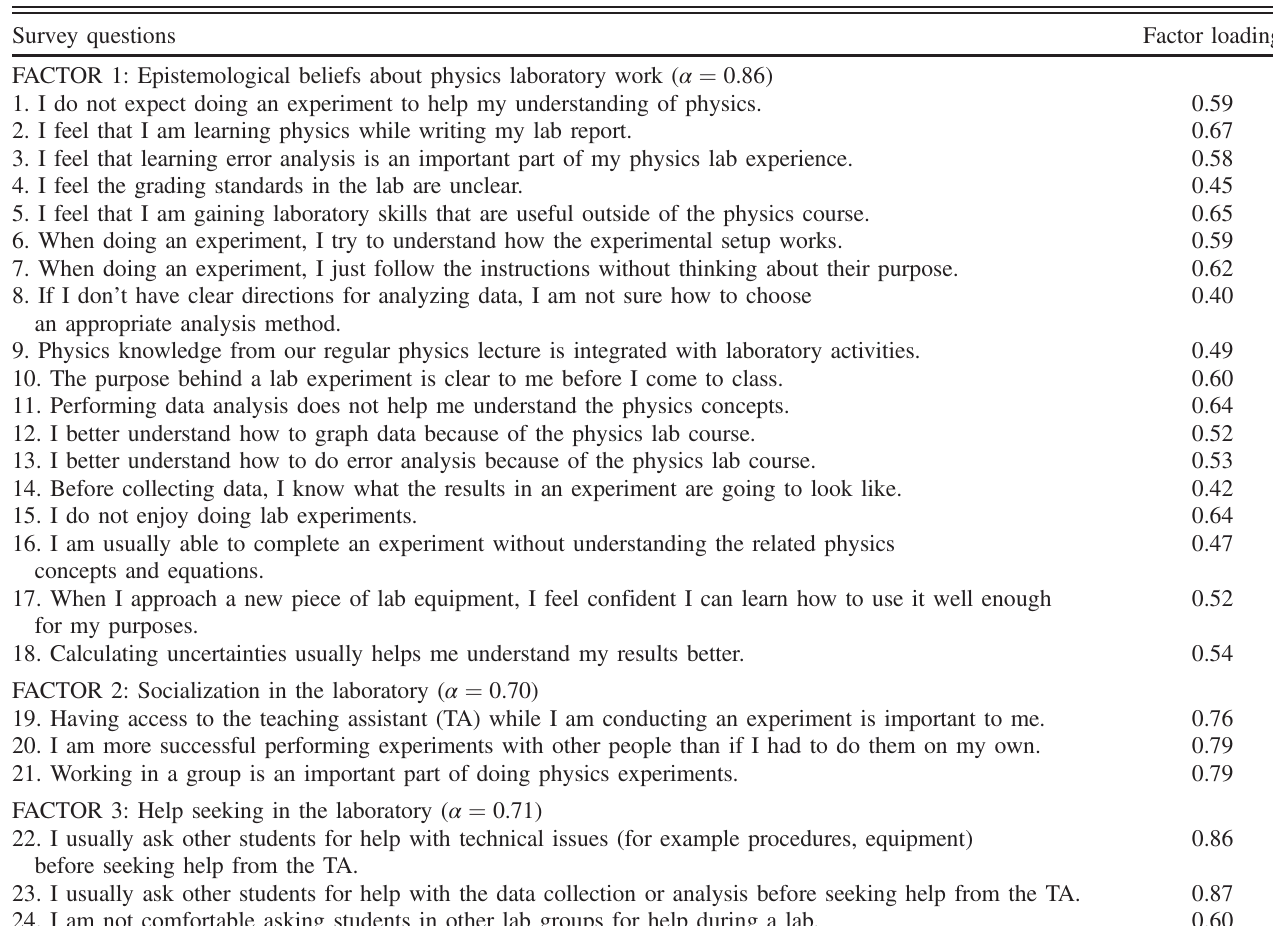
TABLE II. Survey of factors related to epistemological views, socialization, and help seeking in the physics laboratory. Survey questions Factor loading FACTOR 1: Epistemological beliefs about physics laboratory work ( α ¼ 0 . 86